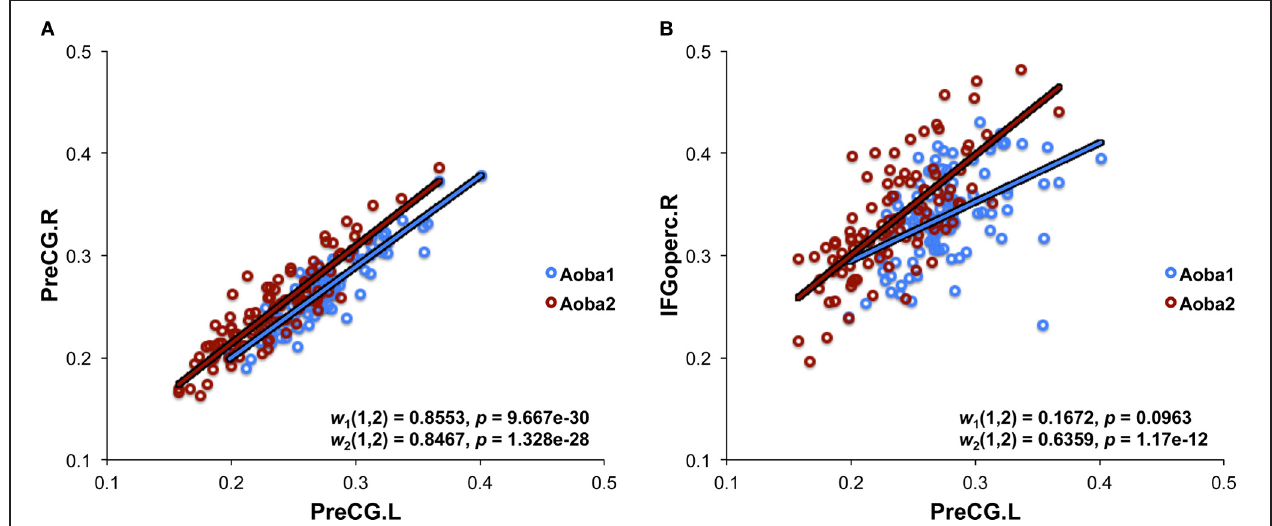
regions ( i and j ) using the measurement of regional gray matter volume, which was corrected by a linear regression analysis to remove the effects of total gray matter volume, age, sex, and age-by-sex interaction. The data from both the baseline (Aoba1, N = 1) and follow-up (Aoba2, N = 2) scans are